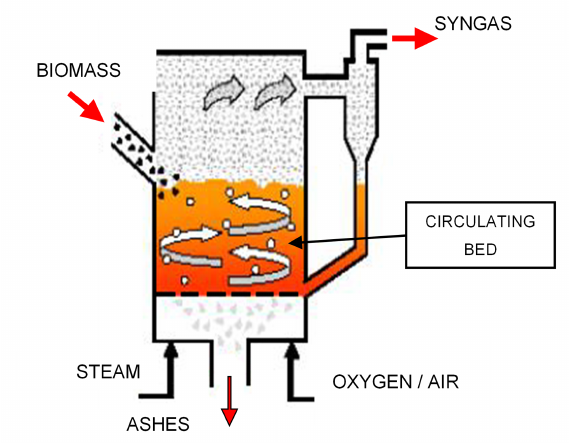
Figure 3. Circulating fluidized-bed gasifier ([12], 2020, adapted by the